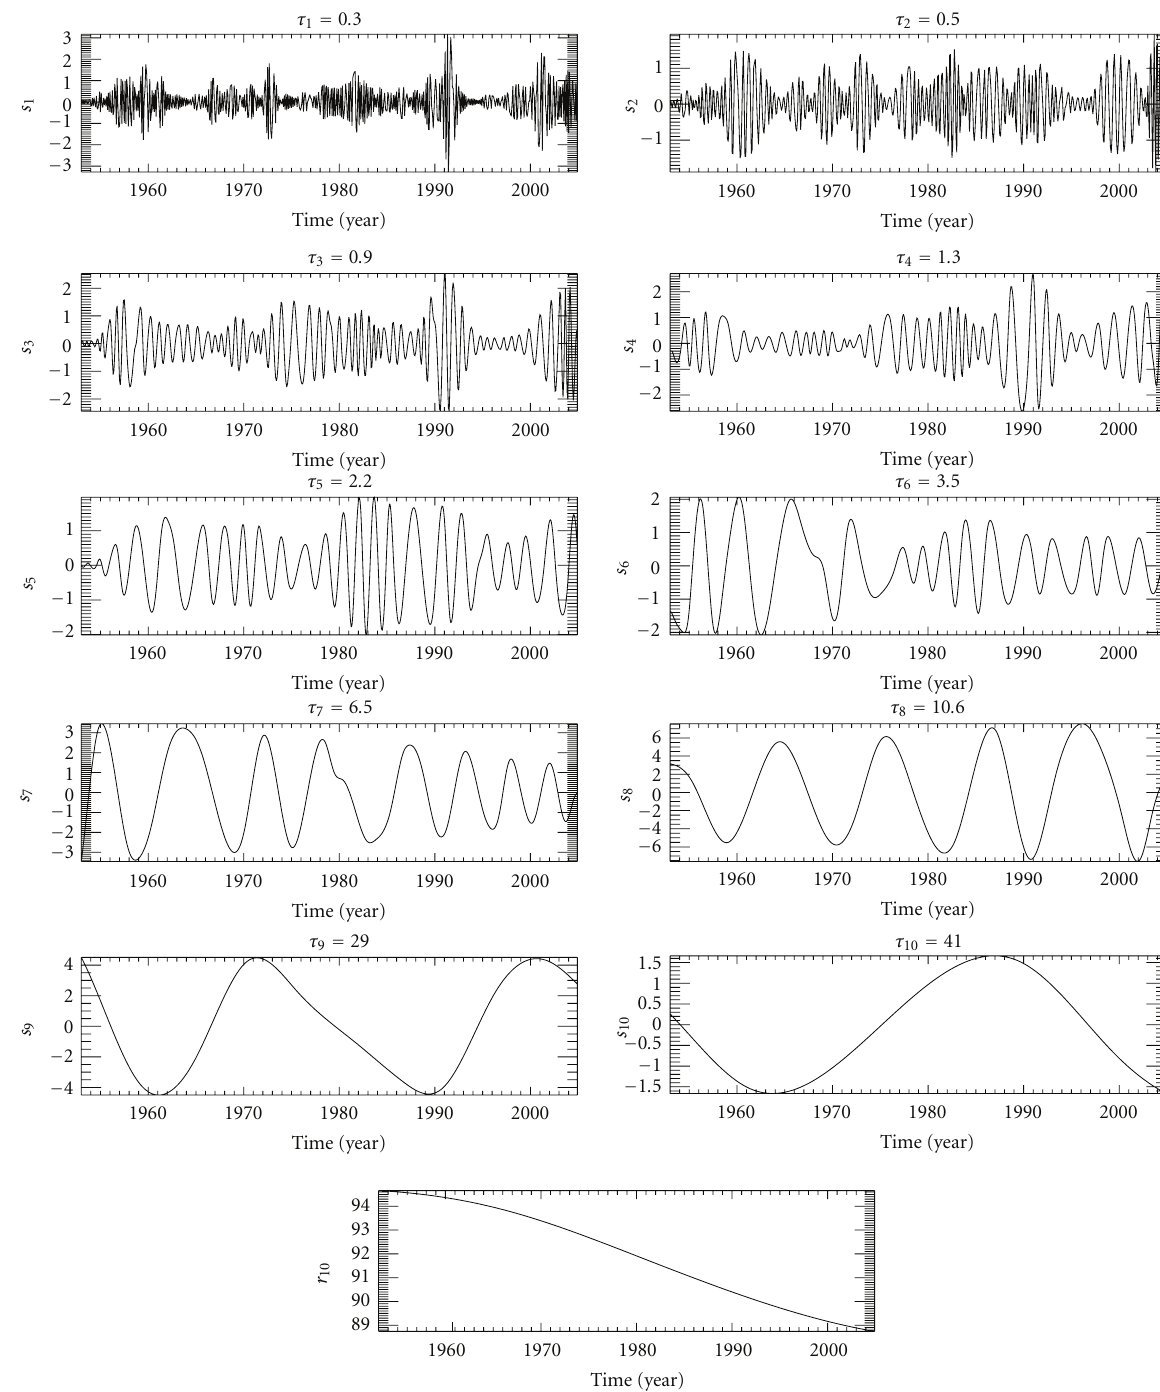
Figure 2: IMFs ( j values from 1 to 10) obtained by performing the EMD on CLI data, along with their characteristic periods τ j in years.